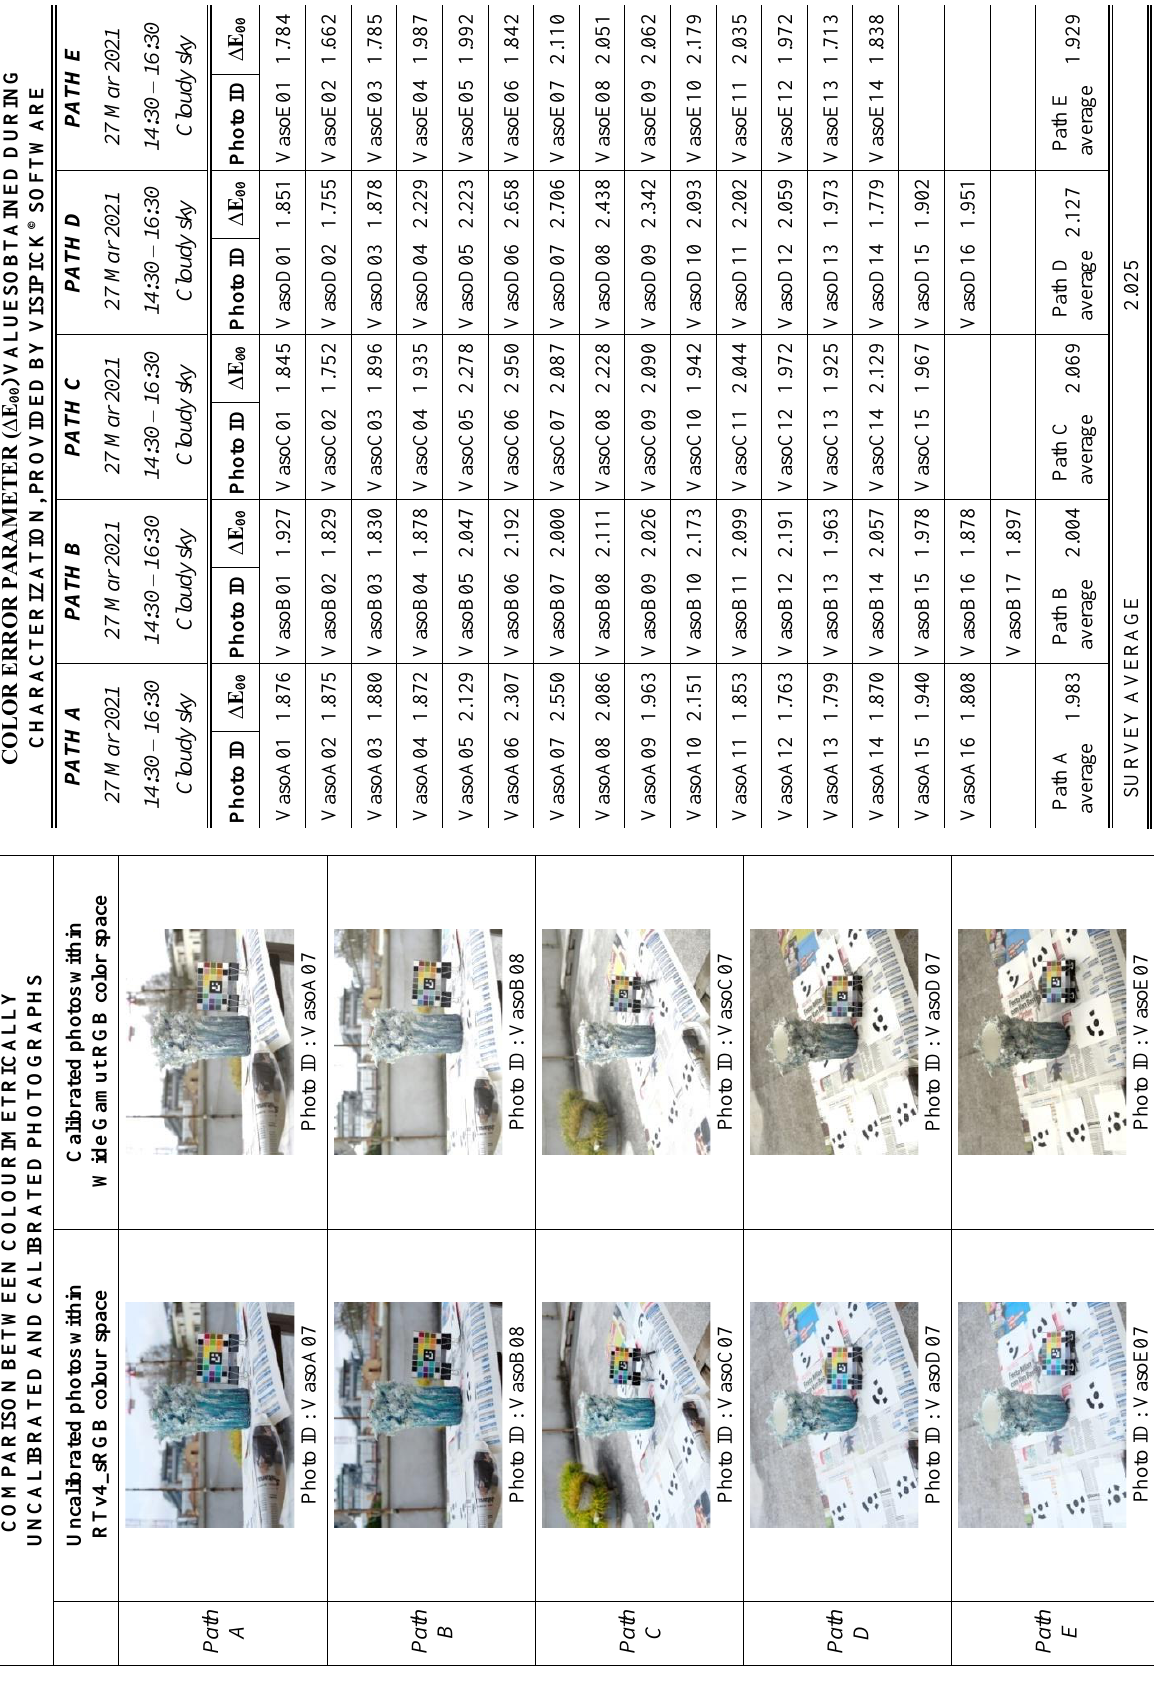
Table 1 . Dataset of Study Case No. 1: the vase with physioplastic decoration in painted